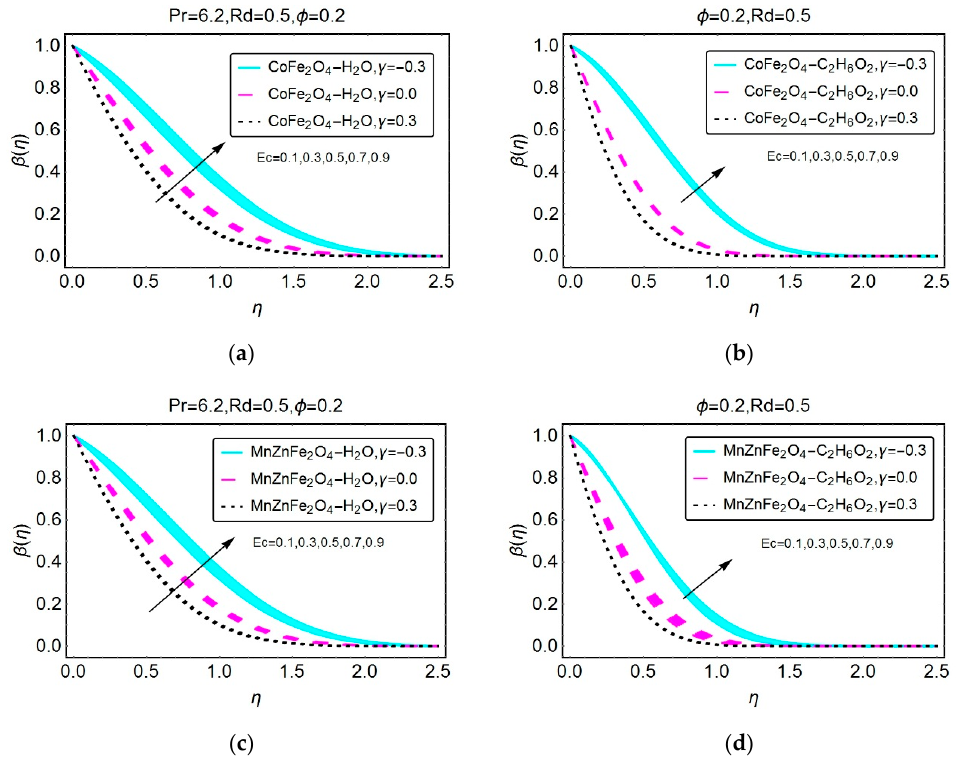
Figure 5. Alterations in the temperature distribution for ( a ) CoFe (cid:2870) O (cid:2872) − H (cid:2870) O ; ( b ) CoFe (cid:2870) O (cid:2872) − C (cid:2870) H (cid:2874) O (cid:2870) ; ( c ) MnZnFe (cid:2870) O (cid:2872) − H (cid:2870) O ; ( d ) MnZnFe (cid:2870) O (cid:2872) − C (cid:2870) H (cid:2874) O (cid:2870) nanofluids by varying 𝐸𝑐 .